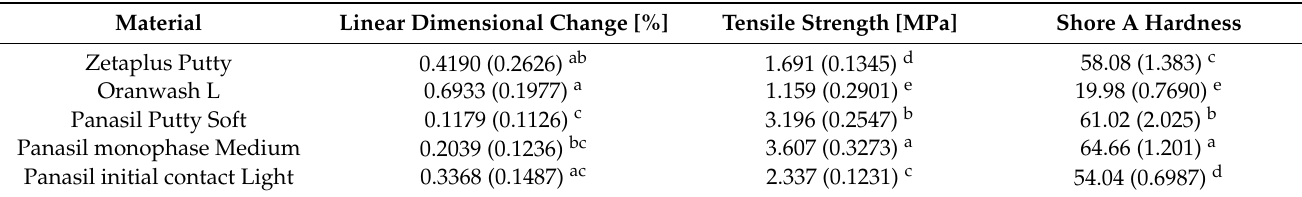
Table 1. Mean (SD) of linear dimensional change, tensile strength, and Shore A hardness for nondis- infected controls of various impression materials; different superscript letters indicate the statistical significance ( p < 0.05) of differences between the studied groups.